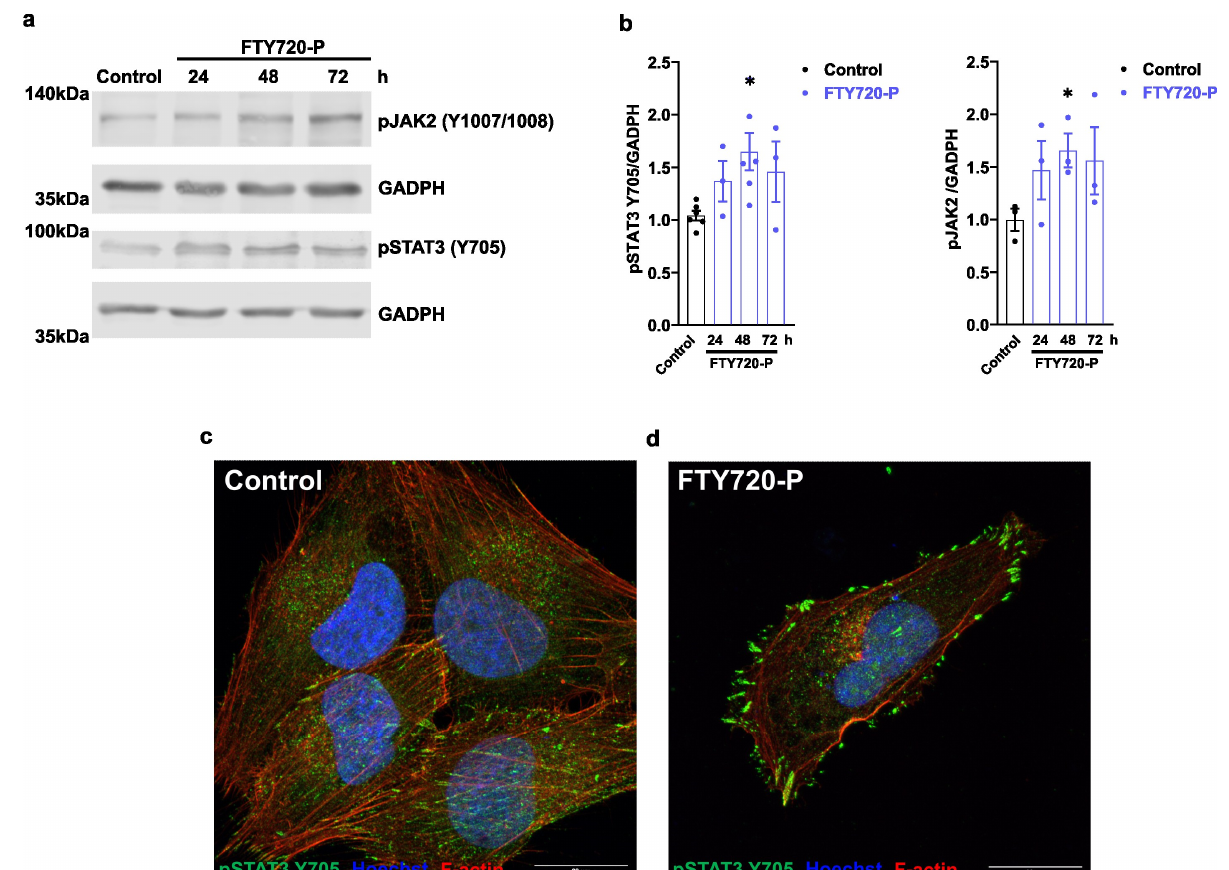
Figure 5. FTY720-P increases JAK2 and STAT3 phosphorylation. ( a , b ) AC16 cells treated with 100 nM FTY720-P for 24 h, 48 h, and 72 h. ( a ) JAK2 phosphorylation (Y1007/1008) and pSTAT3 phosphorylation (Y705) were evaluated by Western blot in total protein extract of AC16 cells. GAPDH was used as a loading control. Densitometric quantification is shown in ( b ). Data were subjected to unpaired t -test. Data are mean ± SEM. * p -value ˂ 0.05 vs. control cells. Graphs represent 3–5 independent experiments. ( c , d ) Representative super-resolution images (Airyscan) of cells stained with pSTAT3 antibody Y705. ( c ) Control AC16 cells incubated with the vehicle, ( d ) AC16 cells incubated with 100 nM FTY720-P for 48 h. pSTAT3 Y705 (green), Rhodamine Phalloidin (red), and nuclei were stained with Hoechst 33342 (blue). Scale indicates 20 μ m.